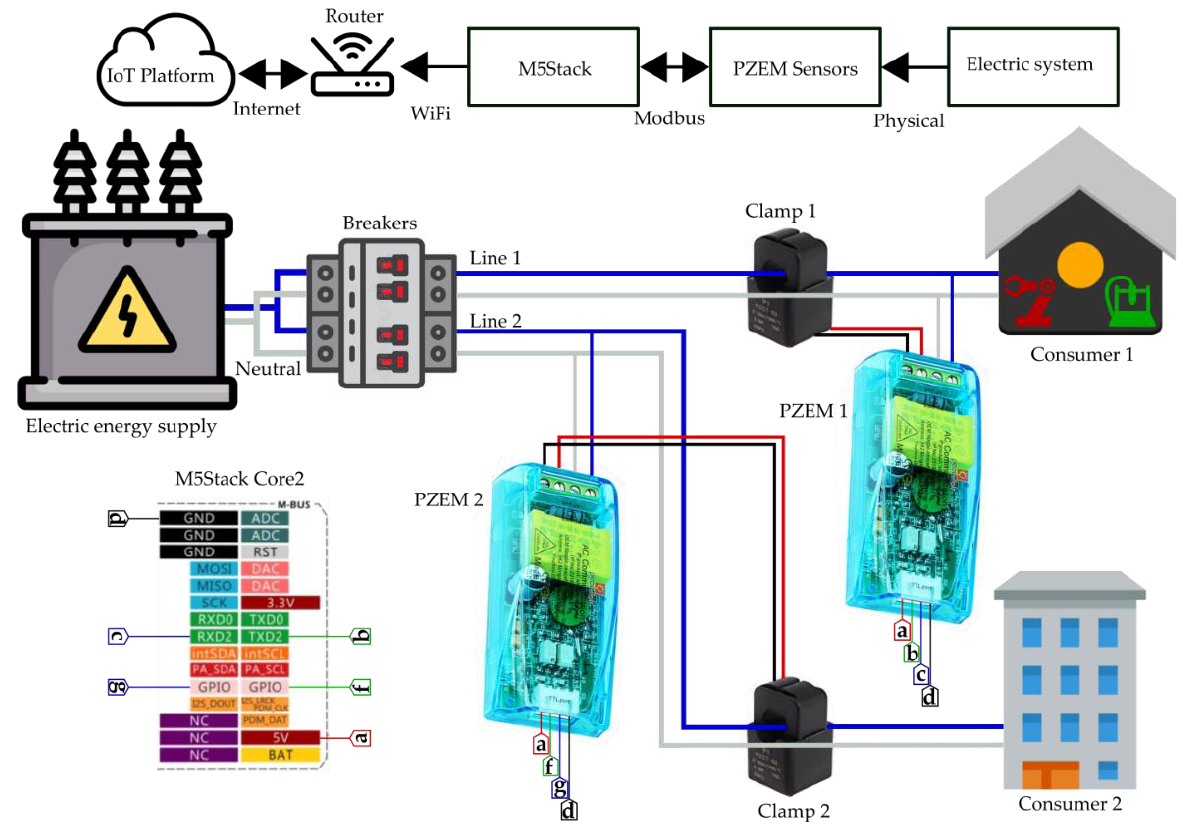
Figure 4. Connections for the acquisition of electrical parameters of two channels.